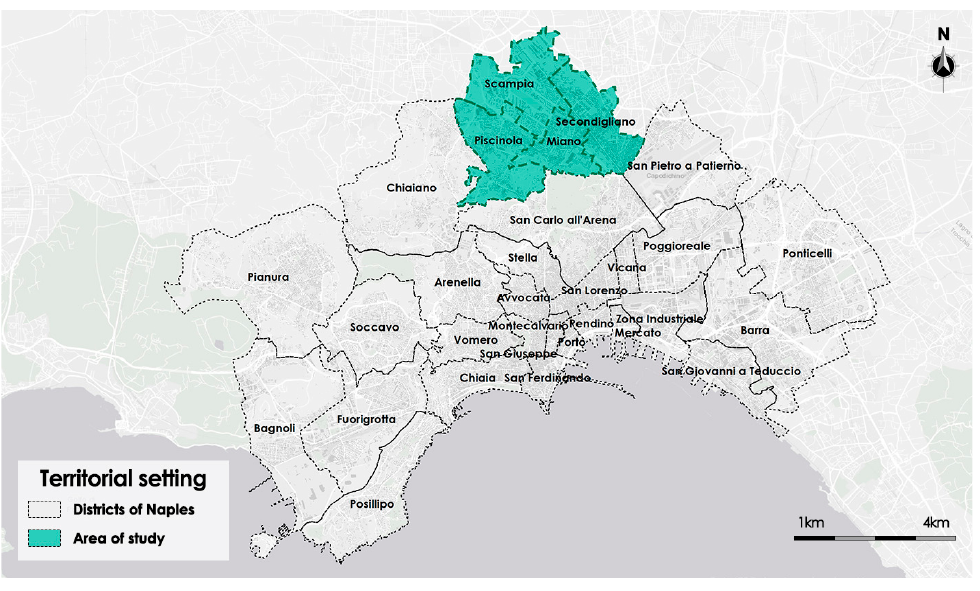
Figure 2. The study area. Table 1. Main characteristics of the four